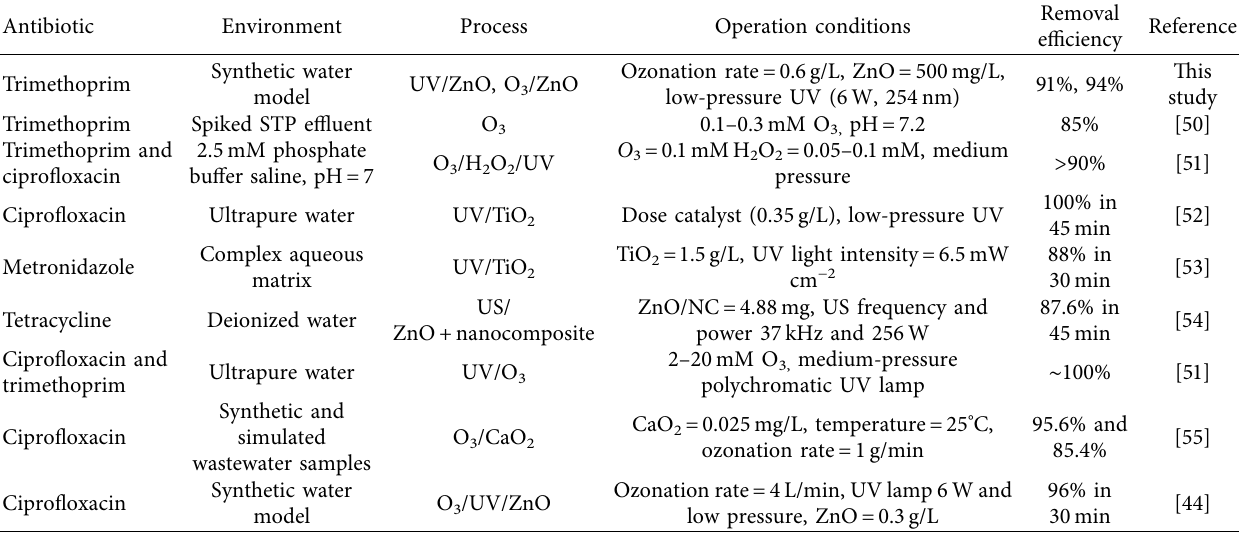
Table 4: Comparison of removal efficiency of antibiotics in aqueous solution by advanced oxidation processes.